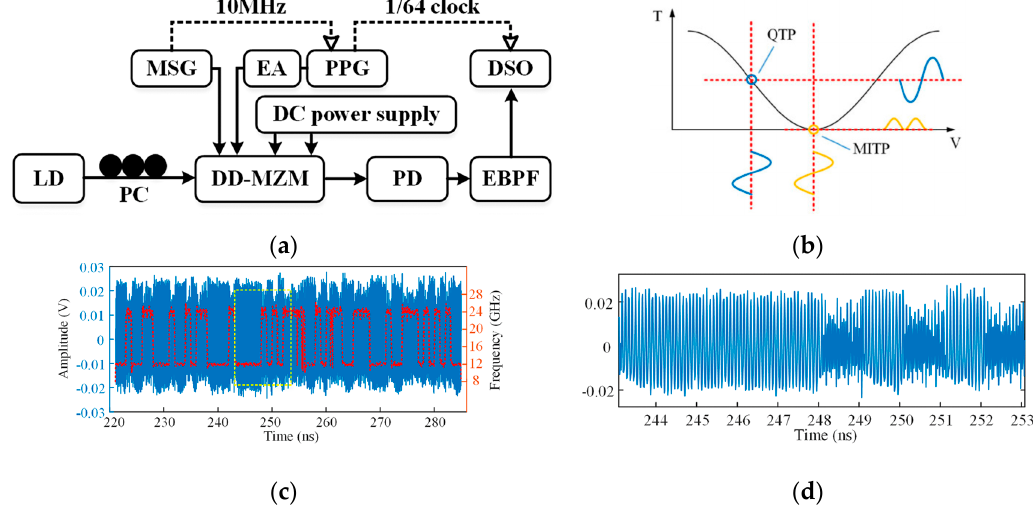
Figure 7. ( a ) Experimental setup of frequency-hopping signal generation by switching the bias point of an optical dual-drive Mach–Zehnder modulator: LD, laser diode; PC, polarization controller; DD-MZM, dual-drive Mach–Zehnder modulator; MSG, microwave signal generator; PPG, pulse pattern generator; EA, electrical amplifier; PD, photodetector; EBPF, electrical bandpass filter; DSO, digital sampling oscilloscope.; ( b ) Transmission characteristics of the DD-MZM at quadrature (QTP) and minimum (MITP) biasing points. ( c ) The measured frequency-hopping signal waveforms (blue solid line) and the calculated instantaneous frequencies (red dotted line). ( d ) A zoom-in view of the generated frequency-hopping RF signal in the yellow dotted line region in ( c ) (with the courtesy of Dr Y. Chen).